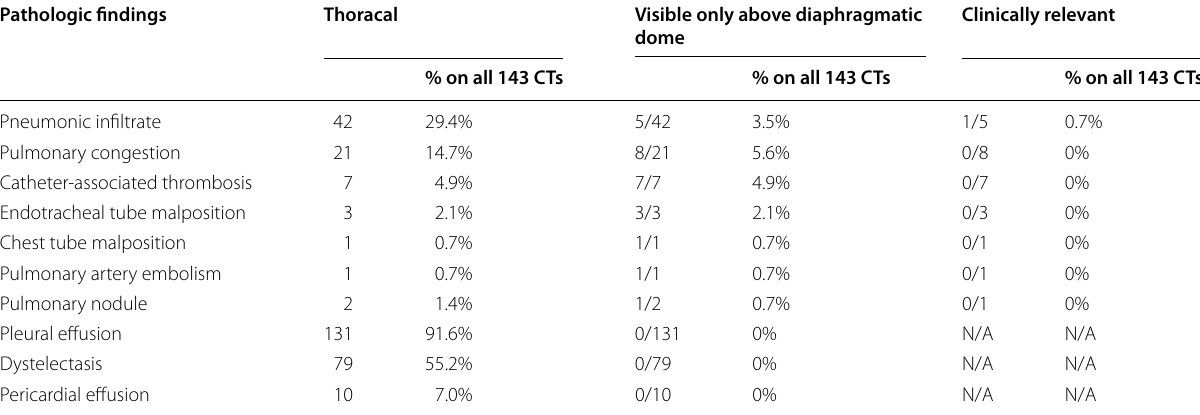
Table 2 Pathologic thoracic findings in thoracoabdominal CT Pathologic